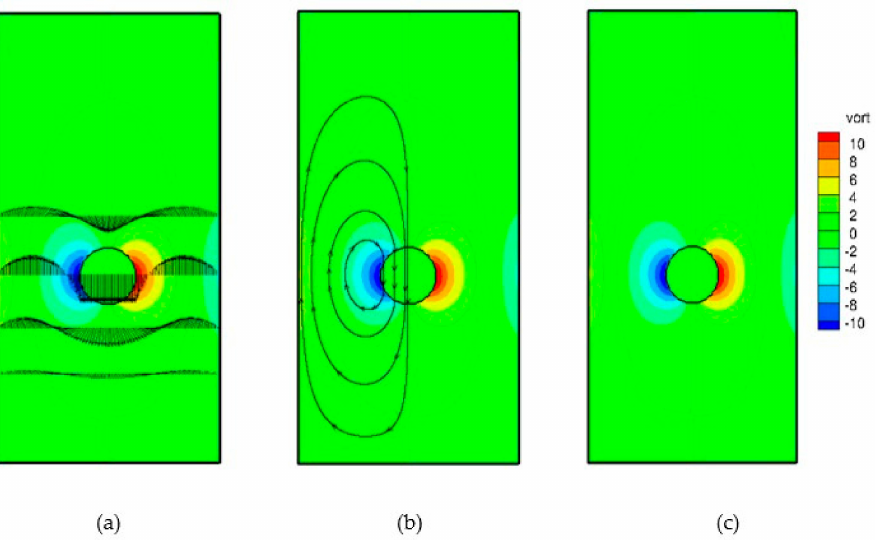
Figure 11. Velocity profiles ( a ), streamlines ( b ), and vorticity contours ( c